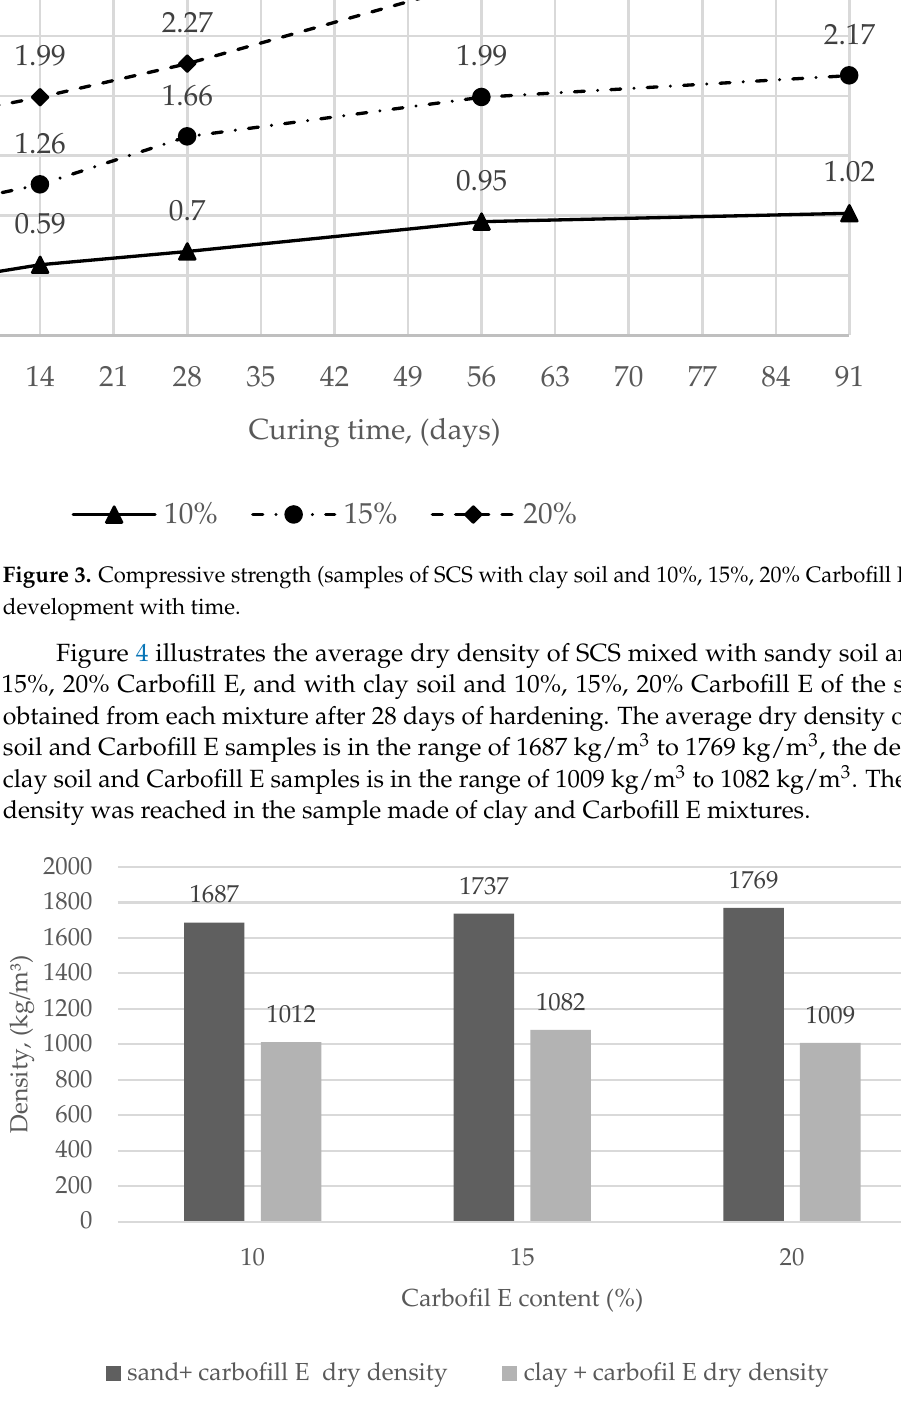
Figure 4. Density of SCS with sandy and clay soils corresponding to the amount of Carbofill E binder. The water permeability of hardened SCS with sandy and clay soils is shown in Figure 5. The coefficient of permeability of SCS mixed with sand and 10 %, 15%, 20% Carbofill E was found to vary between 4.28 × 10 −8 m/s and 2.04 × 10 −11 m/s, while the coefficient of permeability of SCS mixed with clay and 10 %, 15%, 20% Carbofill E was found to vary between 4.56 × 10 −10 m/s and 3.84 × 10 −10 m/s.